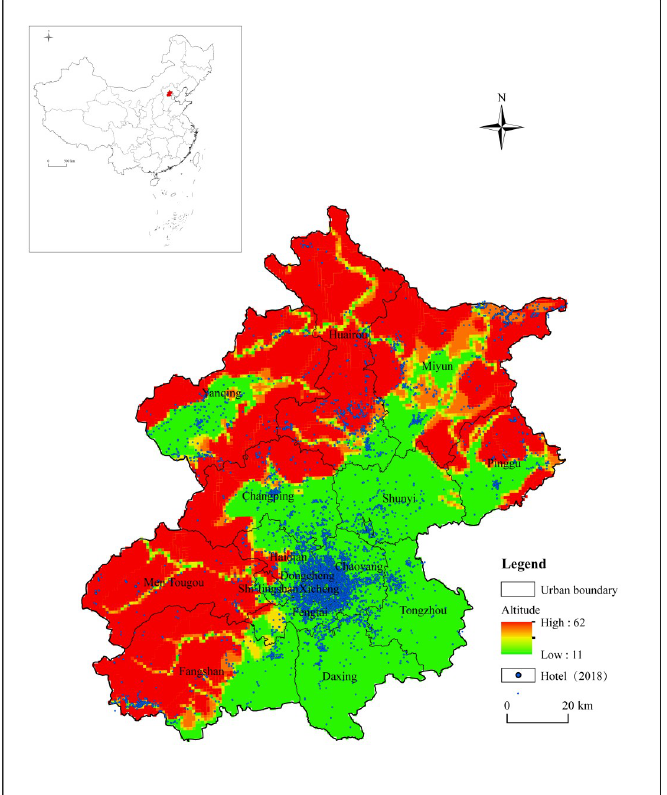
Fig 1. The overview of the study area and the study sample distribution. The color represents altitude, the darker the area, the higher the altitude. The blue dots represent all hotels in Beijing. The data comes from publicly available data on the Internet, which is organized by the authors themselves. The figure is drawn by Arc